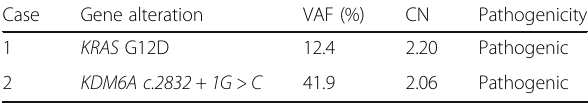
Table 1 Gene alterations in tumor